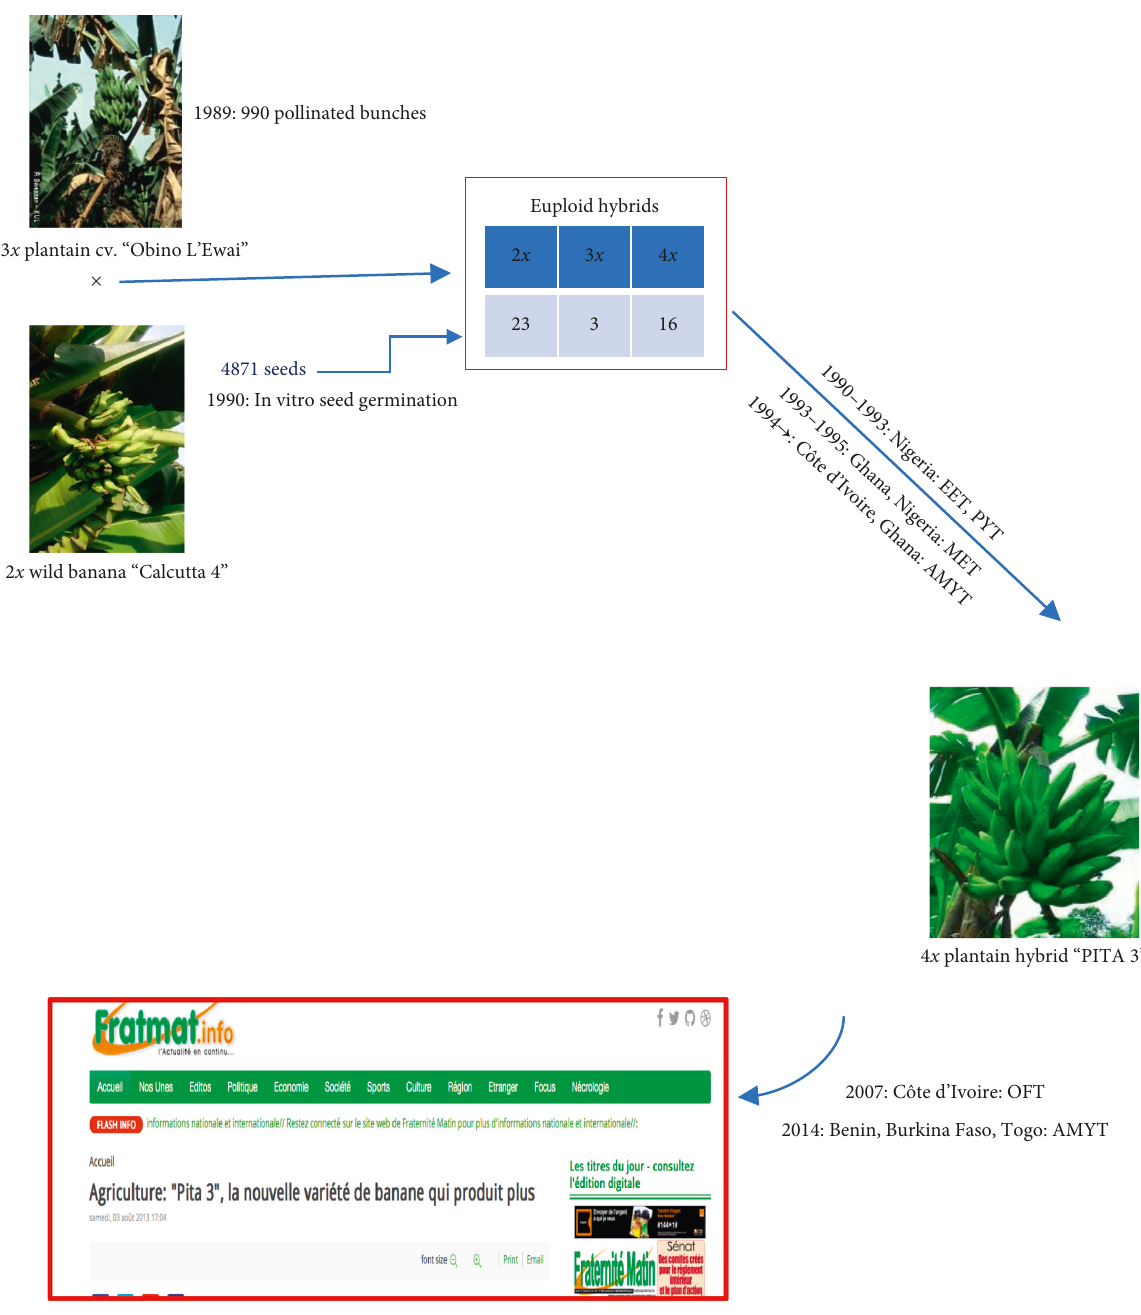
Figure 1: The making of “PITA 3”—a tetraploid (4 x ) primary hybrid bred by the International Institute of Tropical Agriculture (IITA, Nigeria) in partnerships with Council for Scientific and Industrial Research/Ministry of Food and Agriculture/University of Ghana (Ghana), Centre National de Recherche Agronomique (Cˆote d’Ivoire), Institut de l’Environnement et de Recherches Agricoles (Burkina Faso), and Institut National des Recherches Agricoles du Benin (Benin)—as a new plantain cultivar for West Africa. Source for crossing